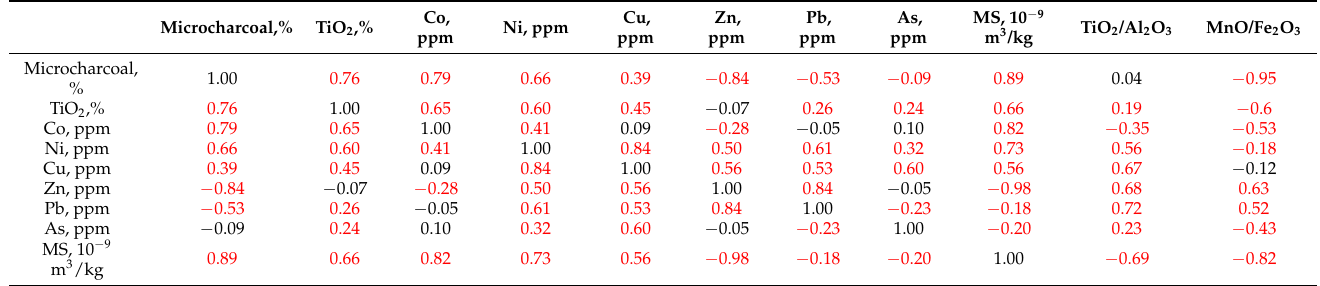
Table 1. Spearman rank order correlations (MD pairwise deleted) of trace metal concentrations, TiO 2 /Al 2 O 3 and MnO/Fe 2 O 3 , MS and charcoal. Marked in red are correlations significant at p <